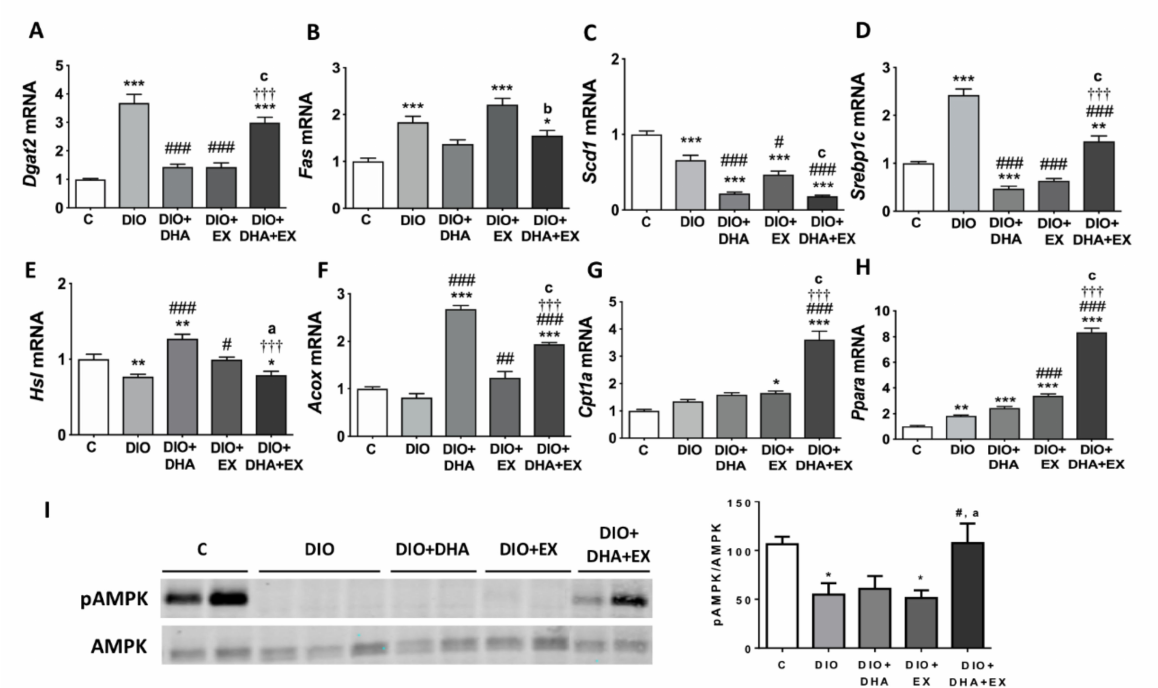
Figure 2. Long-term DHA supplementation and/or aerobic exercise training regulates the expression of lipid metabolism related genes/proteins in liver of 18-month-old DIO mice. ( A – H ) mRNA expression levels of genes involved in hepatic lipogenesis ( A – D ), lipolysis ( E ) and fatty acid oxidation ( F – H ). ( I ) Representative Western blot and densitometry analysis of AMPK phosphorylated and total (left panel). Band densities of phosphorylated AMPK were normalized by total AMPK (right panel). Data are expressed as mean ± SEM. n = 6–10. * p < 0.05, ** p < 0.01, *** p < 0.001 vs. C group. # p < 0.05, ### p < 0.001 vs. DIO group. ††† p < 0.001 for DIO + DHA vs. DIO + DHA + EX group. a p < 0.05, b p < 0.01, c p < 0.001 for DIO + EX vs. DIO + DHA + EX